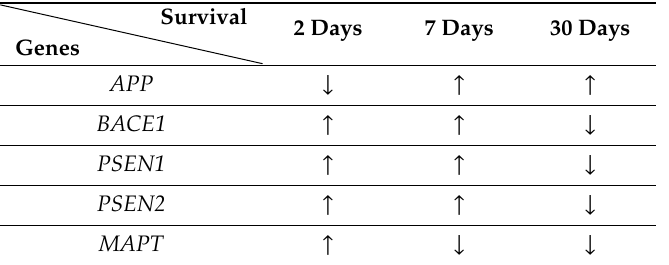
Table 1. Changes in the expression of Alzheimer’s disease-associated genes in the CA1 area of hippocampus at di ff erent times after experimental brain ischemia [62].